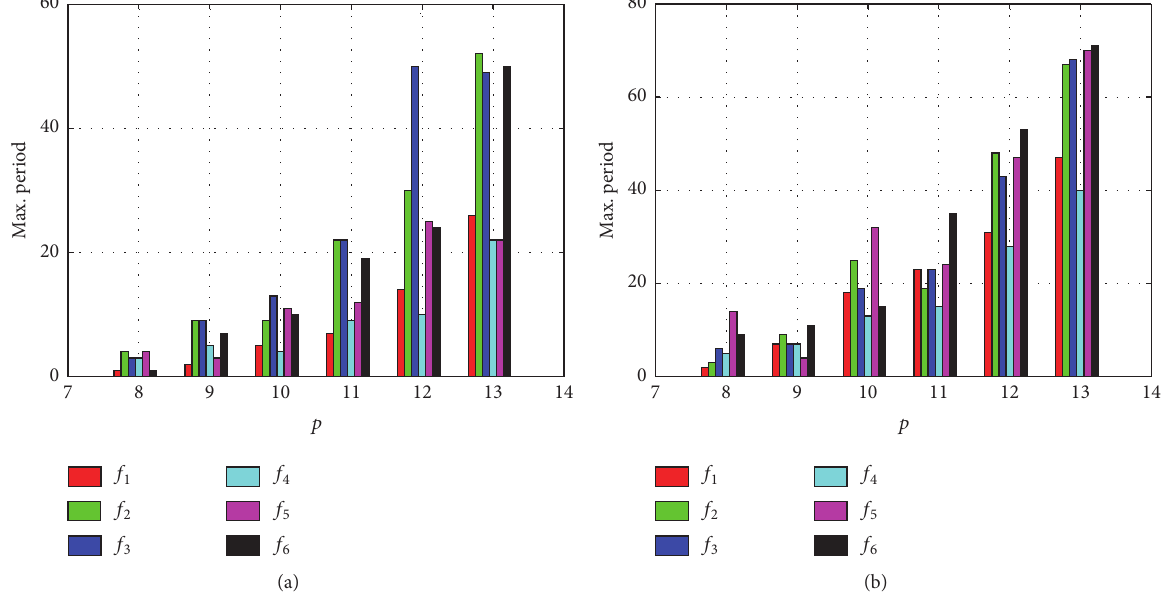
Figure 14: Maximum period obtained with different orders of execution plotted versus precision 𝑝 = 8 → 13 for (a) 𝜆 = 3.8125 : 2 −𝑝 𝑓 : 4 and (b) 𝜆 = −2 : 2 −𝑝 𝑓 : −1.8125 and all initial points allowed by 𝑝